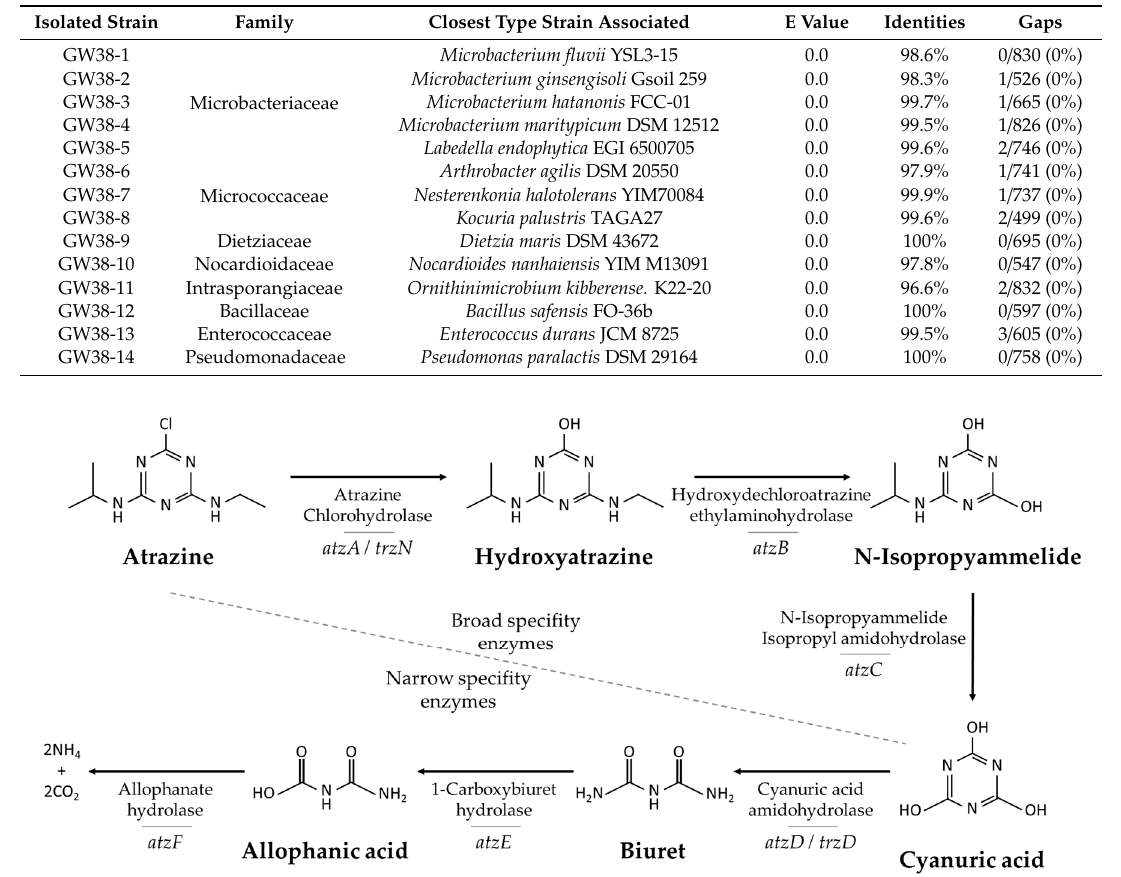
Table 3. Classification and alignment hit table of isolated strains from groundwater.